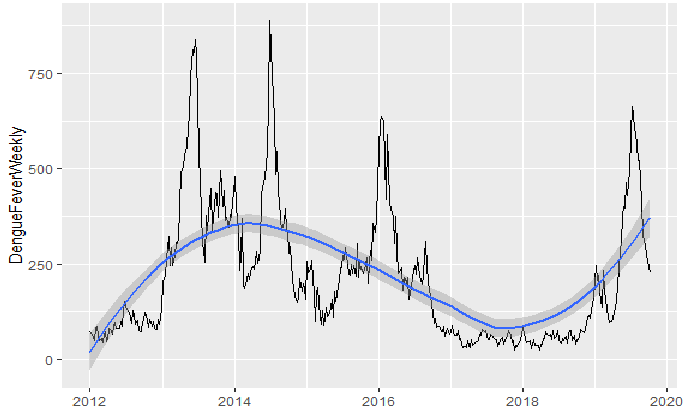
Figure 1. Weekly number of dengue fever cases with smoothed